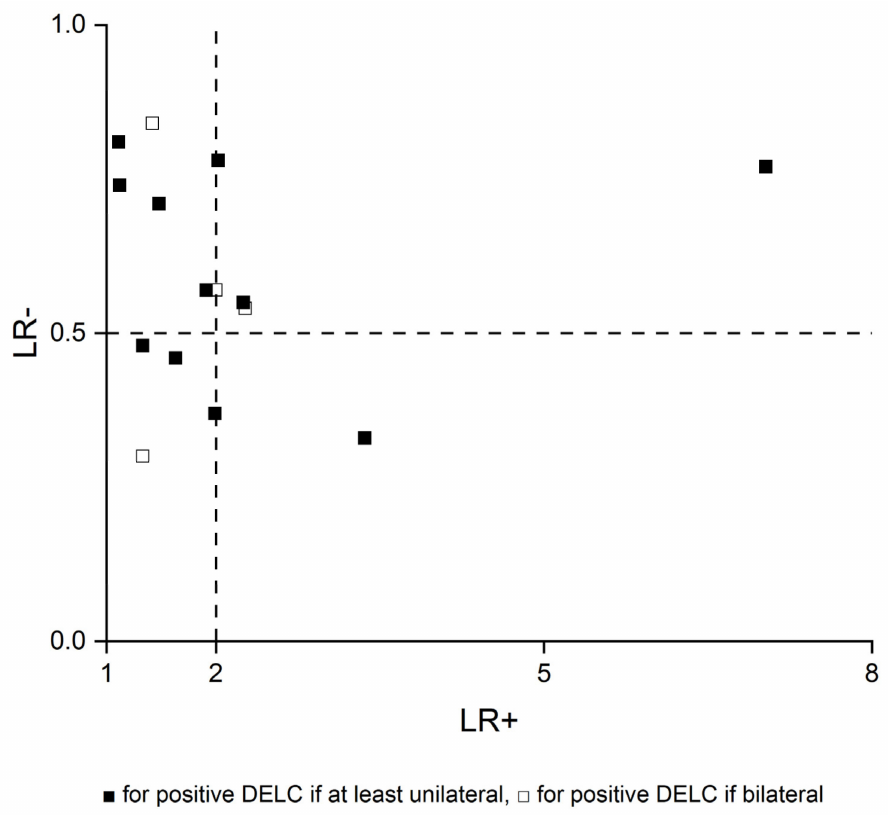
Figure 8. Scatter plot of positive and negative likelihood